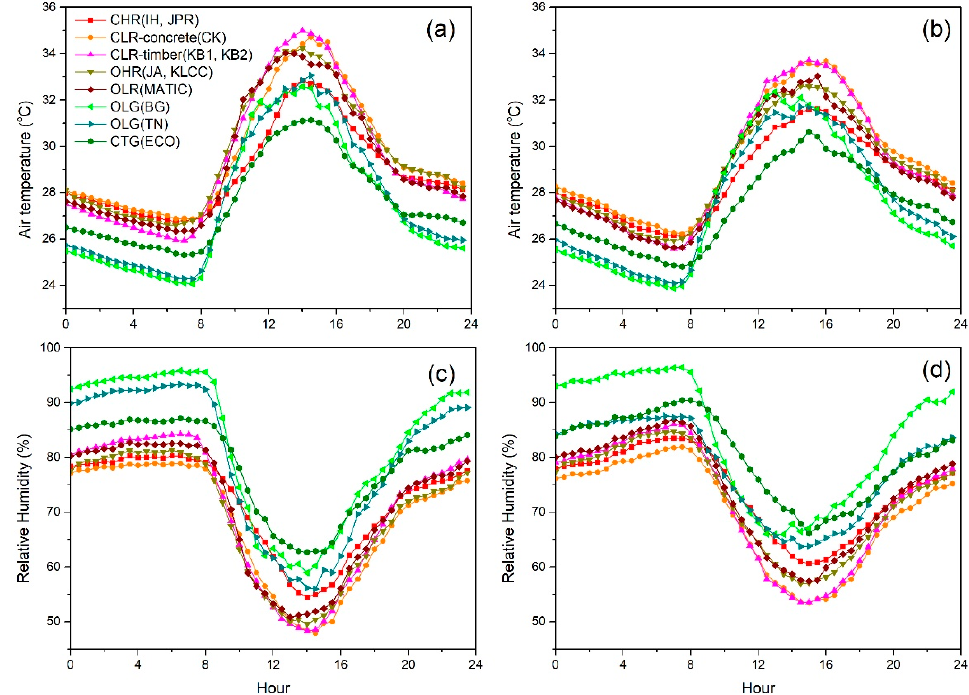
Figure 4. Diurnal variation of air temperature (T) and relative humidity (RH) in wet ( a , c ) and dry ( b , d ) seasons for different land use areas.